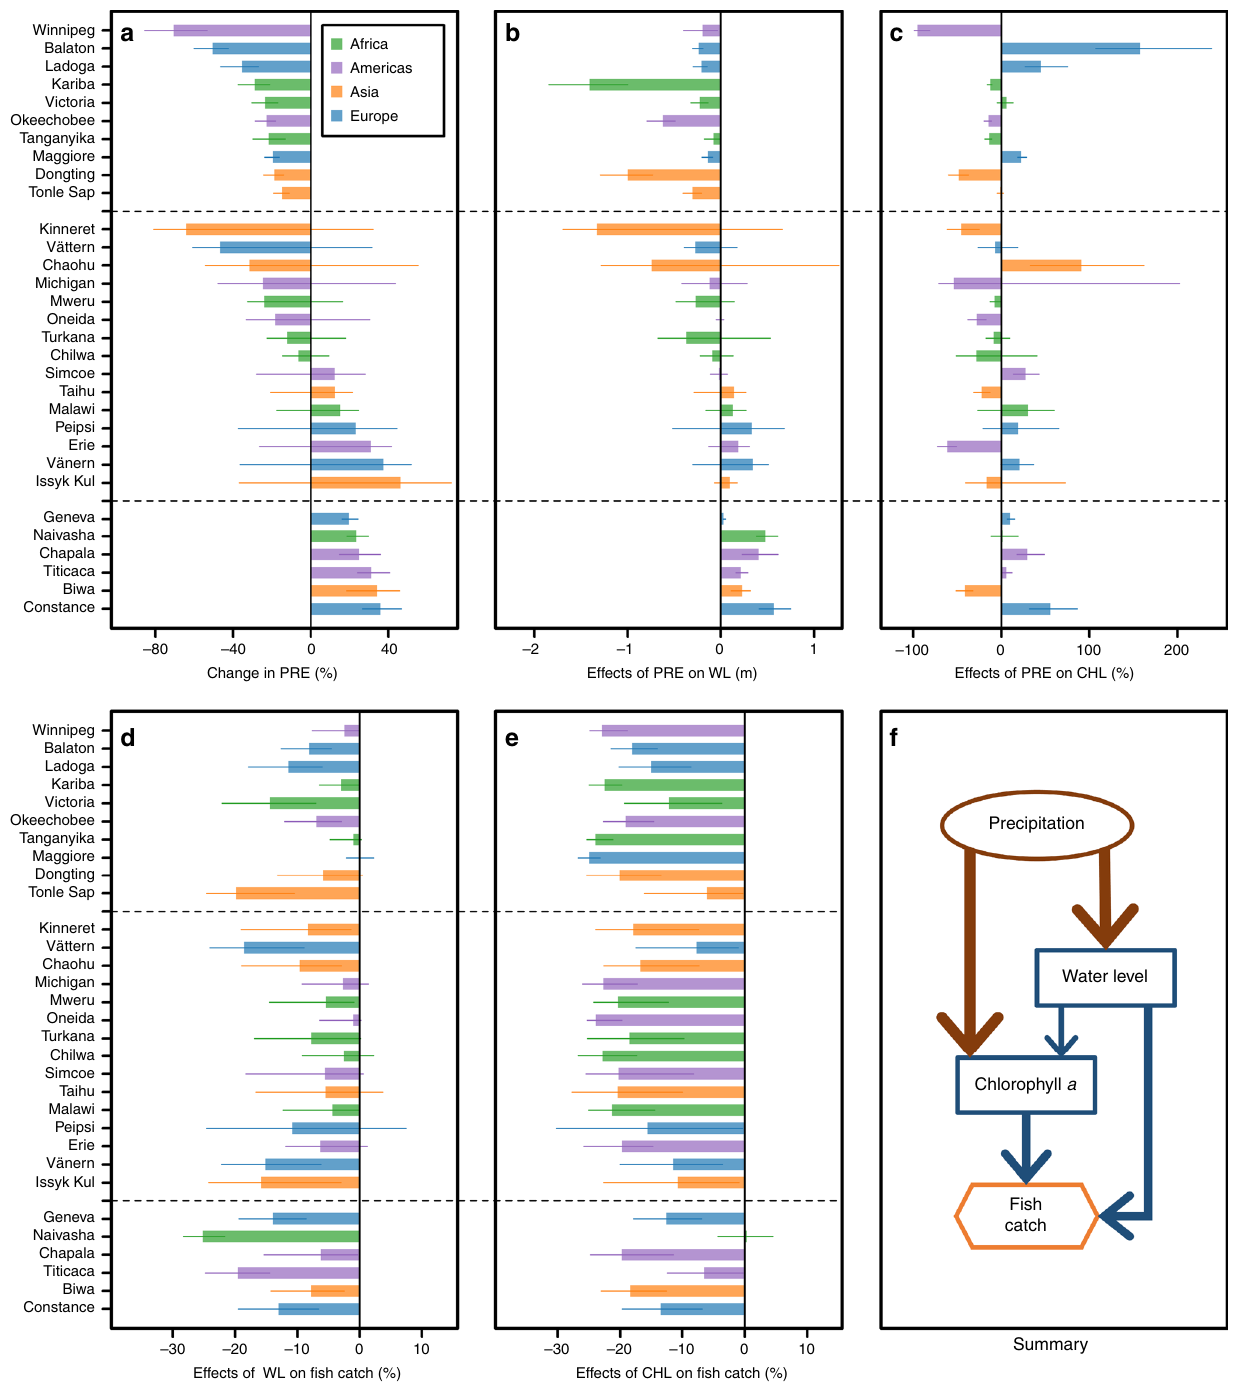
Fig. 5 Assessment for effects of precipitation on fi sh catches across the 31 study lakes. Changes or effects were calculated as differences (actual or relative) from the 1970 – 2014 medians. a shows simulated changes in precipitation (PRE) associated with a 25% decrease in fi sh catches. b , c show simulated effects of changes in PRE on water level (WL) and chlorophyll a (CHL). d , e depict how simulated effects of WL and CHL, in response to changing PRE, affected fi sh catches. h summarizes these linkages within a subset of the Bayesian networks model that demonstrates the effects of PRE, where the width of each arrow is a qualitative indicator of the strength of the hypothesized causal effects. In a – e , bars represent simulated median changes and error bars represented fi rst and third quartiles of the simulated changes. Dashed lines divide the lakes into “ positive ” (top 10 lakes), “ mixed ” (middle 15 lakes), or “ negative ” (bottom 6 lakes) associations between PRE and fi sh catches, based on one-tailed 75% credible intervals, as indicated by error bars in a . For positive lakes, a 25% decrease in fi sh catches was associated with lower PRE. For mixed lakes, a 25% decrease in fi sh catches was associated with both lower and higher PRE. For negative lakes, a 25% decrease in fi sh catches was associated with higher PRE. Source data for a – e are provided as a Source Data fi